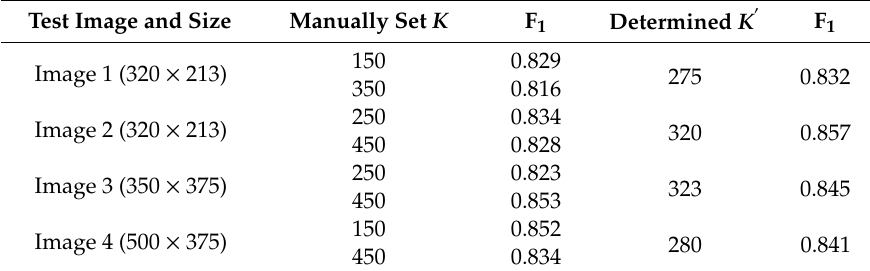
Figure 6. Comparison of results under different numbers of initialized superpixels, where K and K ′ indicate respectively the number of superpixels set manually and generated by the proposed method. Table 1. The effect of different K values on the precision of segmentation.